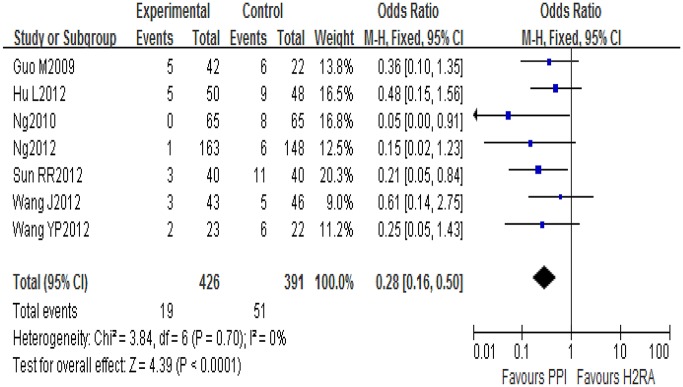
H2RAs and PPIs for prevention of LDA-associated GI ulcers/erosions.